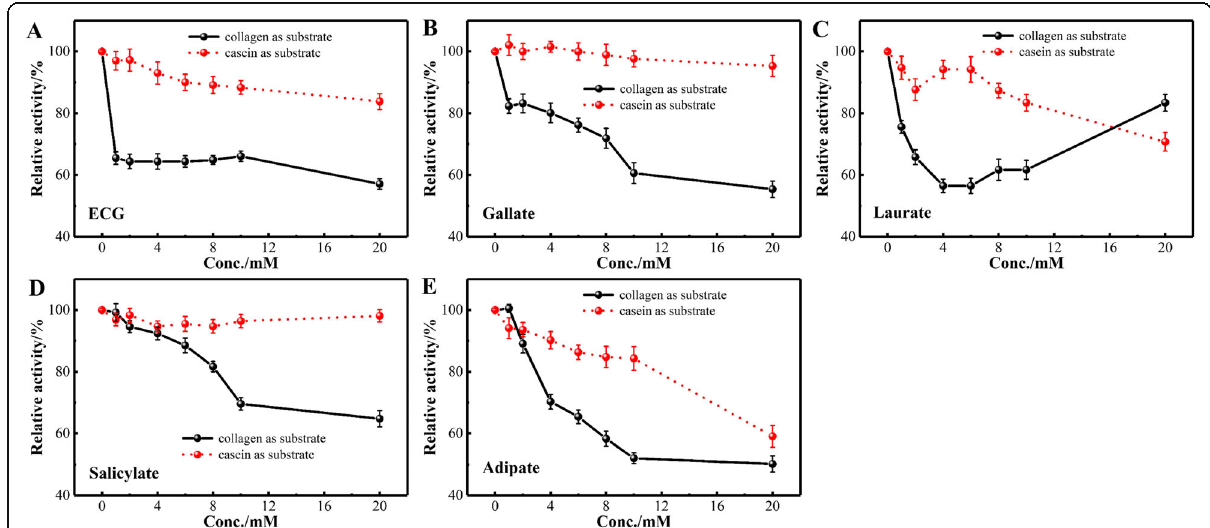
Fig. 2 The effect of organic additives on the hydrolytic activity of proteinase